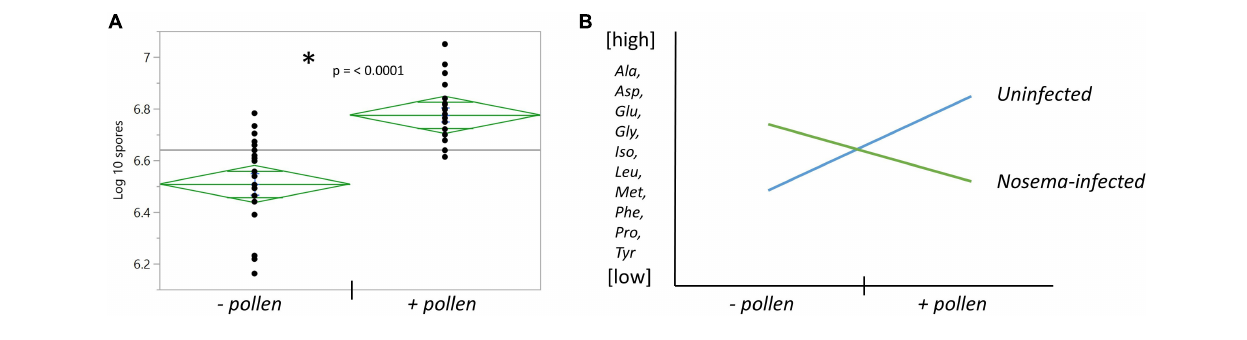
FIGURE 3 | The effects of pollen and Nosema ceranae on spore count and amino acid relationships with pollen. (A) The number of spores counted in the abdomens of bees infected with N. ceranae ± pollen. *Asterisk denotes significance between groups measured by a t - test ( t ( 38 ) = 5.31, p ≤ 0.0001). (B) The general relationship between pollen and N. ceranae in 10 of 18 amino